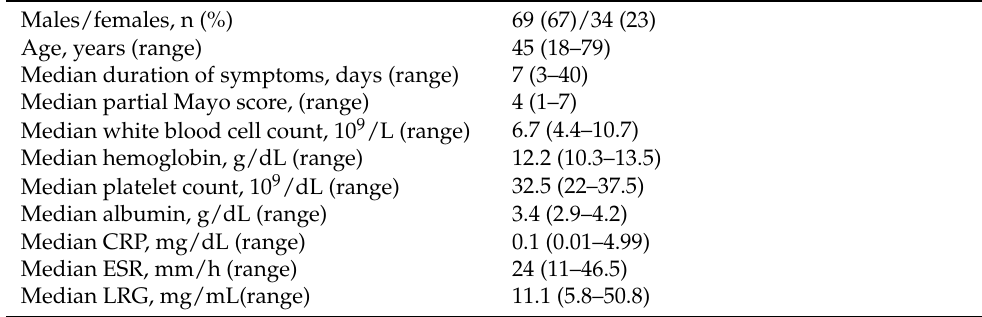
Table 1. Enrolled subjects’ characteristics and their clinical findings (n =